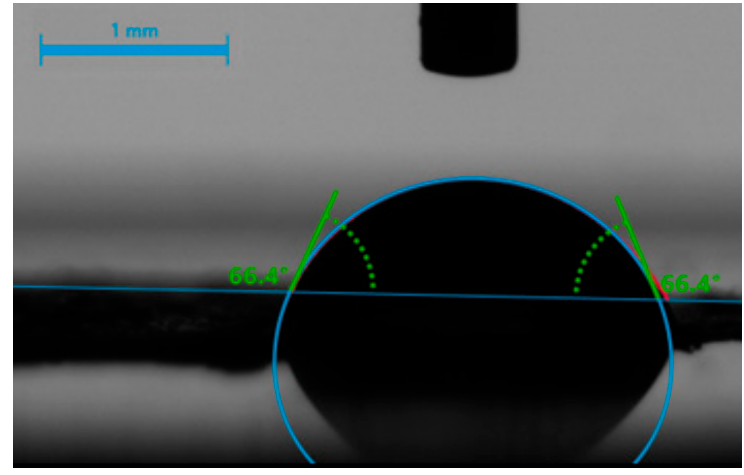
Figure 16. Contact angle measurement of a water droplet (2 µL) on a BTCP-AE-FM